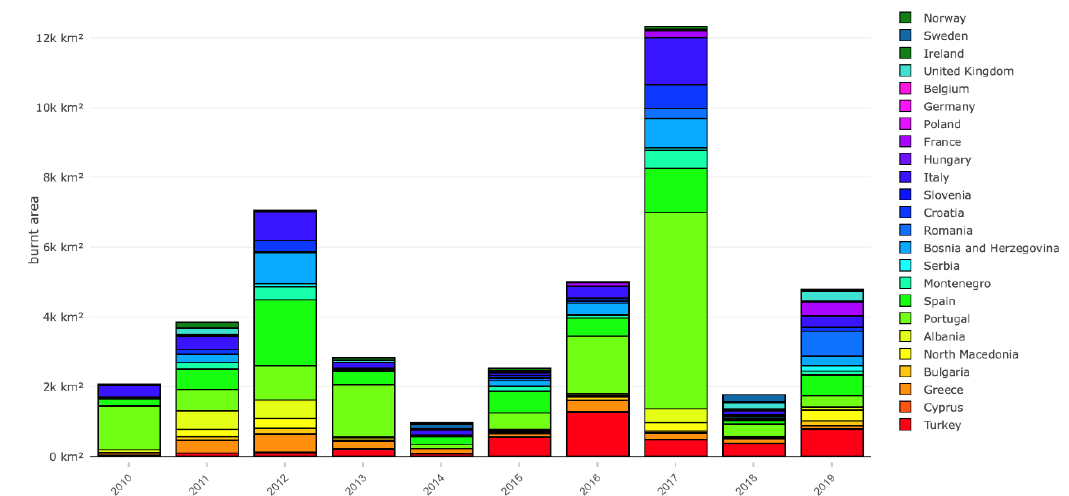
Figure 2. Burnt area by European country from 2010 to 2019, EFFIS. Source: EFFIS, 2020. On average, Europe suffers from over 1000 fires burning an area larger than 50 hec- tares per year, with a yearly average total of 300,000 hectares burnt. Furthermore, 2017 was an exceptional year, especially in the south west of Europe, with 2225 fires and a total of 1,236,138 hectares burnt. After a normal 2018, 2019 also proved particularly severe, with